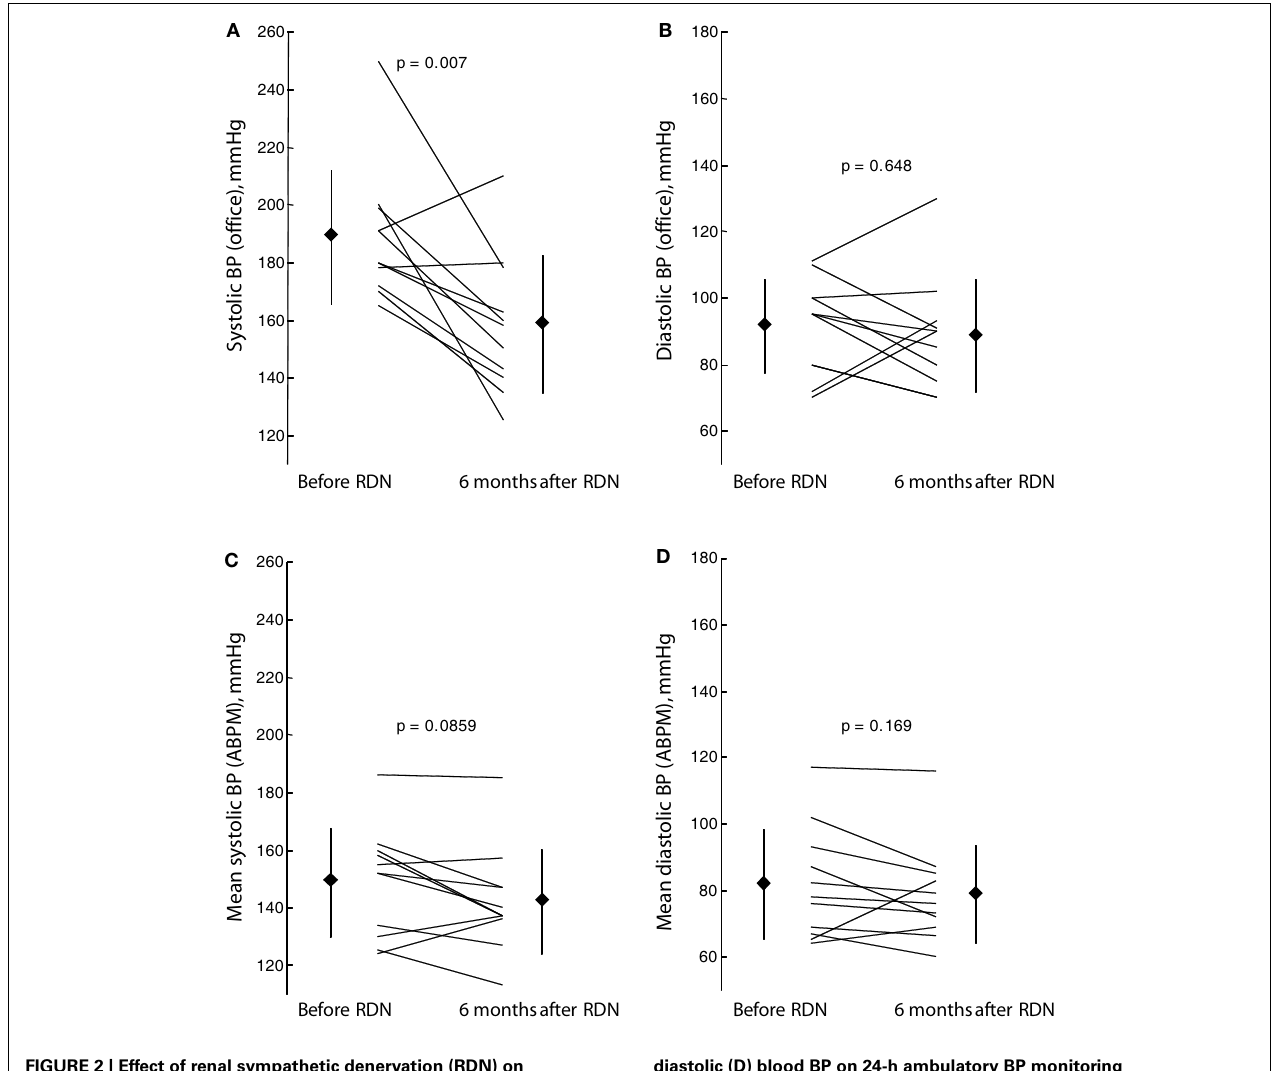
FIGURE 2 | Effect of renal sympathetic denervation (RDN) on mean levels of blood pressure (BP): office systolic (A) and diastolic (B) BP as well as mean levels of systolic (C) and